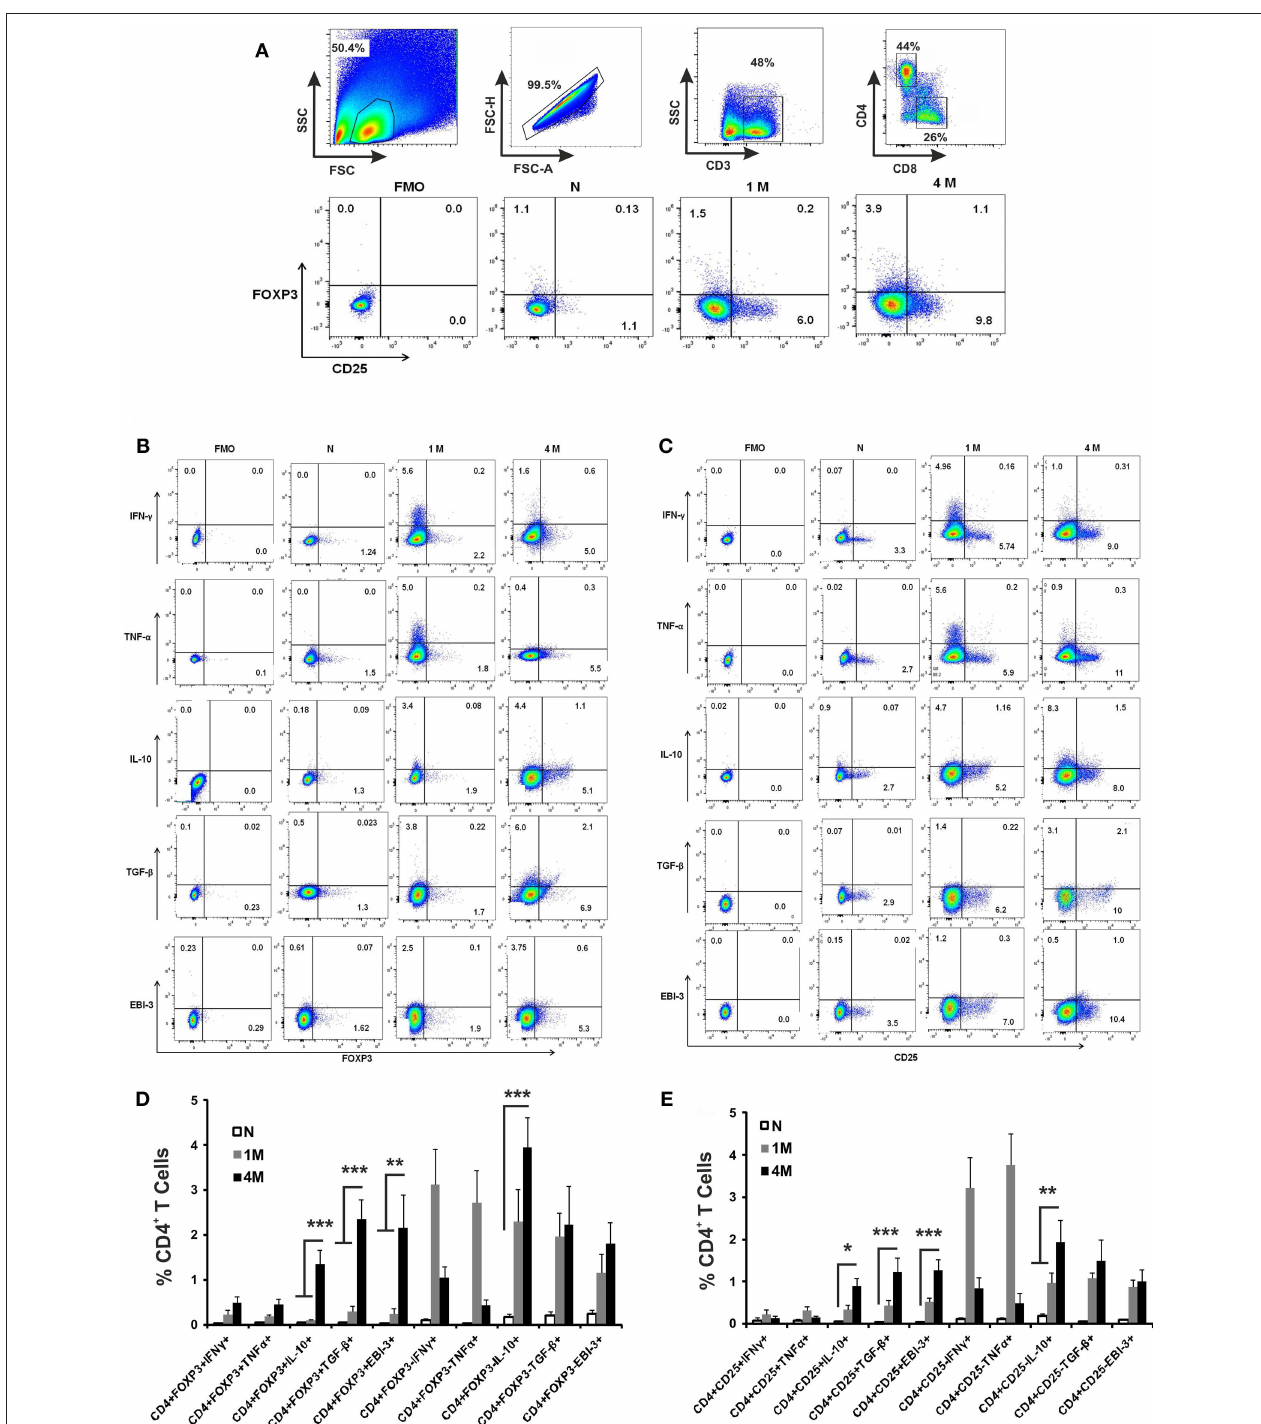
FIGURE 2 | Role of CD4 + T cell subsets in cytokine production during L. donovani infection. Infected and control mice splenocytes were stimulated with Leishmanial membrane antigens (LAg) (10 µ g/ml) overnight and then cells were processed for flow cytometric studies. CD3 + T cells were gated from single cell population of splenic lymphocytes, followed by CD4 and CD8 cells (A) . Subsequently, sub-sets of CD4 cells were gated based on Fluorescence Minus two controls for the identification of IFN- γ , TNF- α , IL-10, TGF- β and EBI-3 positive cells among CD4 + Foxp3 + (B) as well as CD4 + CD25 + (C) as representative dot plots. Data are expressed as means ± SE of percentage of cytokine producing CD4 + Foxp3 + / CD4 + Foxp3 − T cells (D) , and similarly of CD4 + CD25 + / CD4 + CD25 − T cells (E) , for six mice per group with three experimental repeats. Student’s T -tests were applied to compare the differences in percentage proportion of cytokine producing cells as compared to uninfected controls. * P < 0.05; ** P < 0.01; *** P < 0.001.